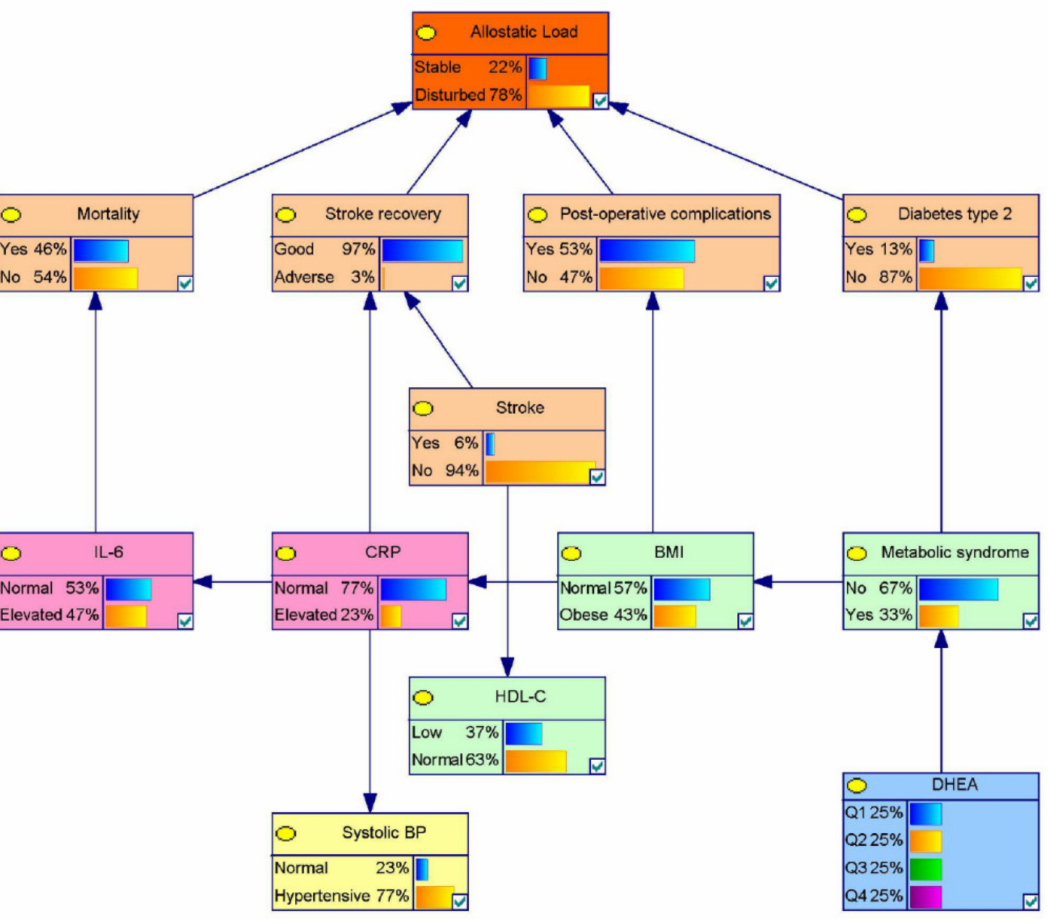
Figure 3. A graphical representation of the probability—allostatic—model for the elderly (>60 years), eventually based on 11 independently published statistical sources (see Table 2). Showing prognostic probabilities on the eventual “overall” outcome, being defined as “allostatic load” (likelihood for progressively deteriorating health). Percentages represent the probability of observing the given level or outcome, in this case, when all states are unobserved. Generated in GeNIe Version 2.3. Note: BMI = Body mass index; BP = Blood pressure; CRP = C-reactive protein; DHEA = Dehydroepiandrosterone; HDL-C = High-density lipoprotein cholesterol; IL-6 =